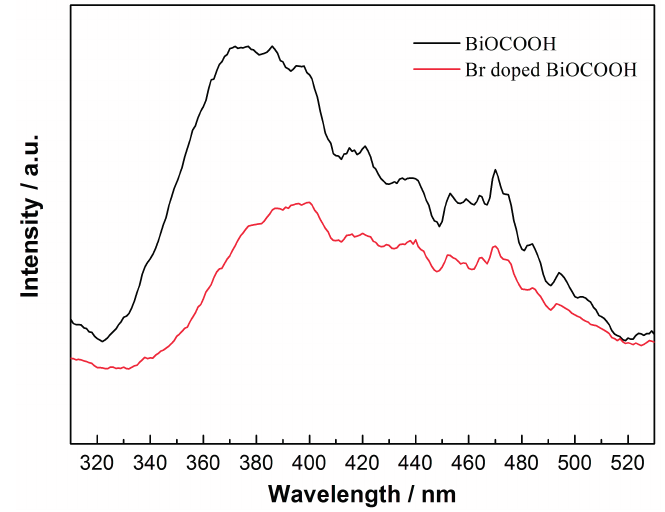
Figure 6. UV-vis DRS spectra of BiOCOOH, BiOBr and BHB with different Br contents.